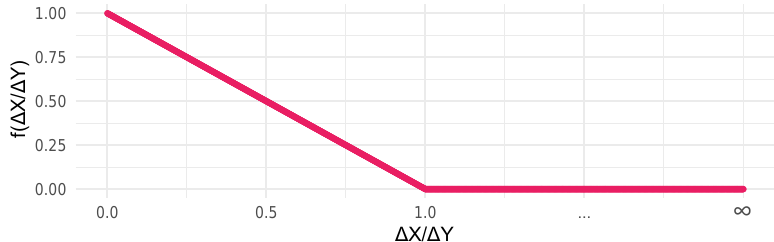
Figure 7. Utility is a function that relates casualties among opponents U i = f ( (cid:52) x / (cid:52) y ) , where (cid:52) x stands for own casualties, and (cid:52) y for enemy casualties. It is worth noting that the utility function is close to 1 for COAs that maximize enemy casualties and minimize their